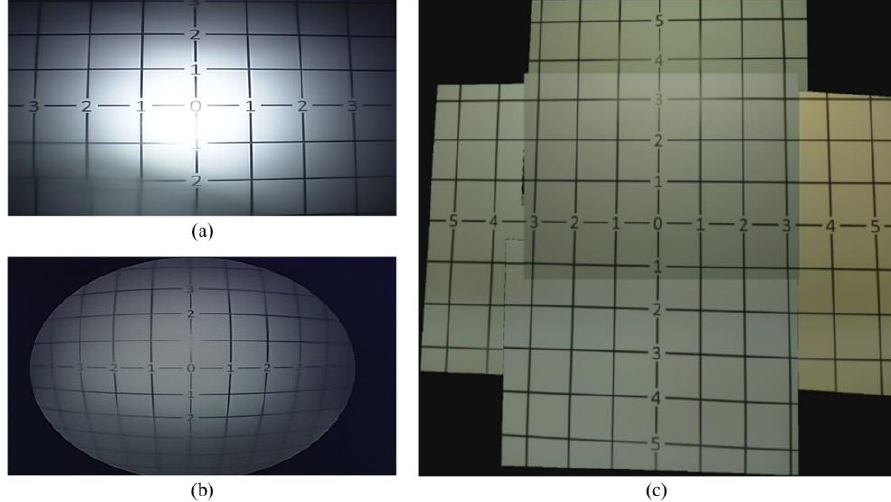
Figure 6. FoV measurement using grid lines printed on a paper sheet. Captured images from ( a ) a 10 mm 0° laparoscopic camera, ( b ) a 5 mm 0° laparoscopic camera, and ( c ) the TCA. The TCA can cover larger FoV compared with commercial laparoscopic cameras. Note the distortion in the view acquired from the 10 mm 0° laparoscopic camera (a) and the 5 mm 0° laparoscopic camera (b).